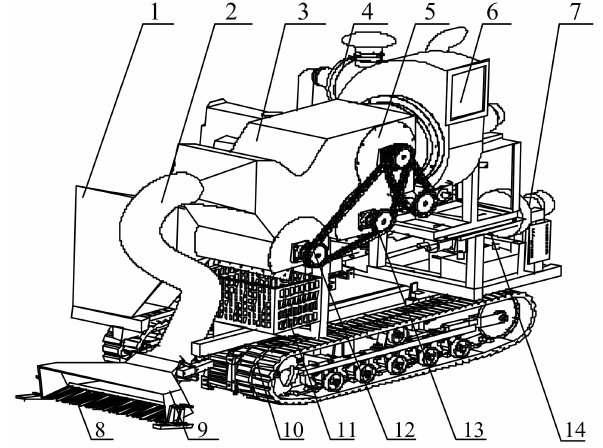
Figure 1. Structure of the provoke-suction type harvester for ground jujube fruit (PSH). 1. Control system 2. Suction pipe 3. Cleaning device 4. Diesel engine 5. Rotary screen 6. Centrifugal fan 7. Oil hydraulic pump 8. Provoke teeth 9. Pickup device 10. Caterpillar chassis 11. Basket 12. Closed-air